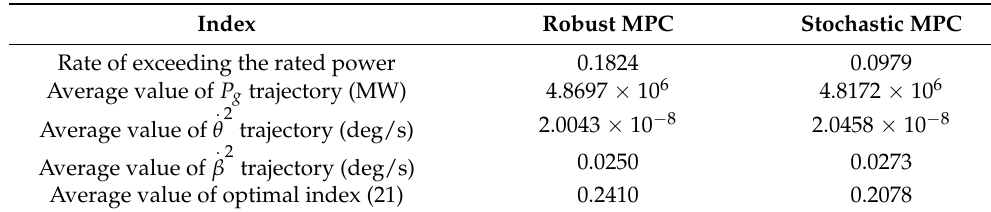
Figure 12. ( a ) Output power P g and ( b ) pitch angle β of WPGS for the robust MPC (red solid line) and stochastic MPC (blue dotted line) in the high wind speed region with severe turbulence. Table 4. The comparing results between robust MPC and stochastic MPC under the slight turbulence.